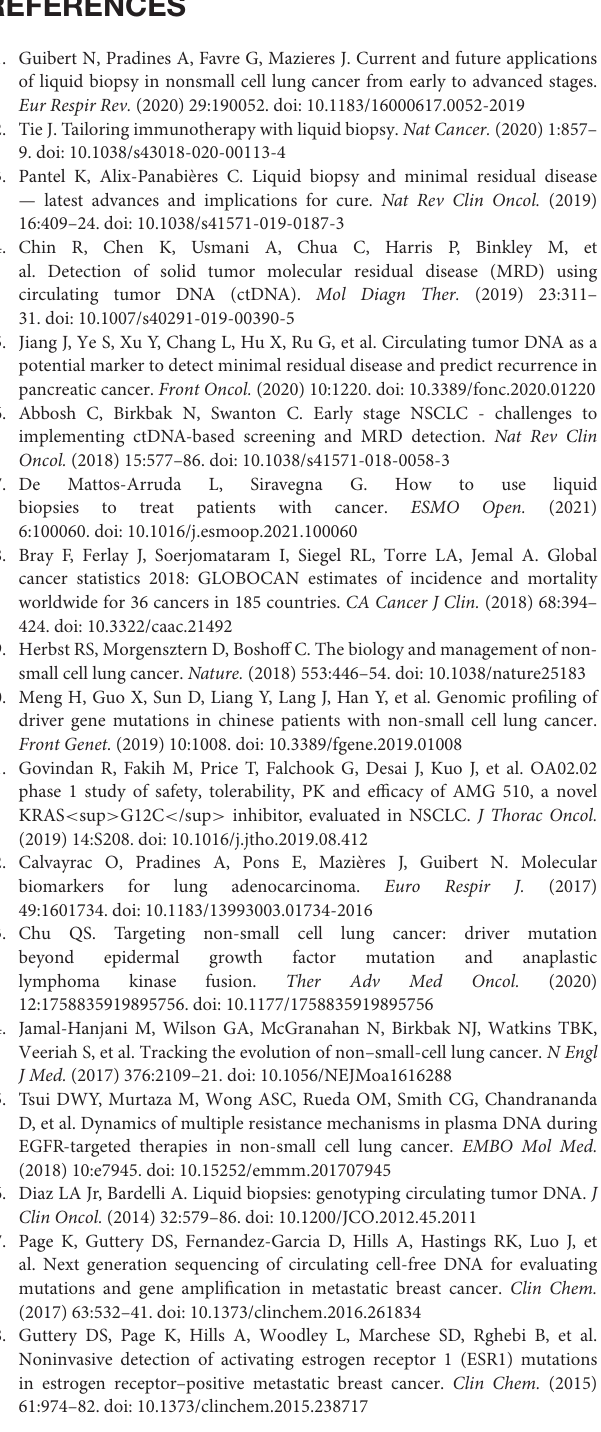
Supplementary Table 6 | Mutation profiles of the 29 lung cancer patients. Supplementary Table 7 | The mutation profiles of matched tissue and blood samples of the 76 NSCLC